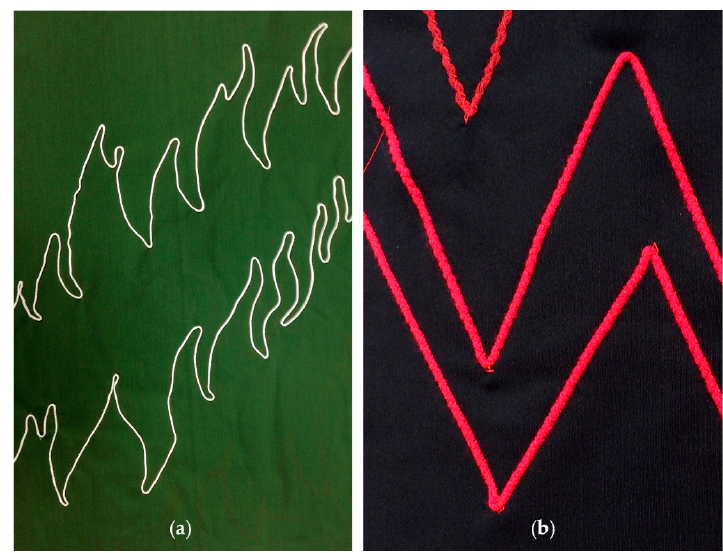
Figure 2. Zig-zag attachment pattern of electronic yarns (E-yarns) to stretch fabric: ( a ) Initial design, and ( b ) Final, more-ordered design.